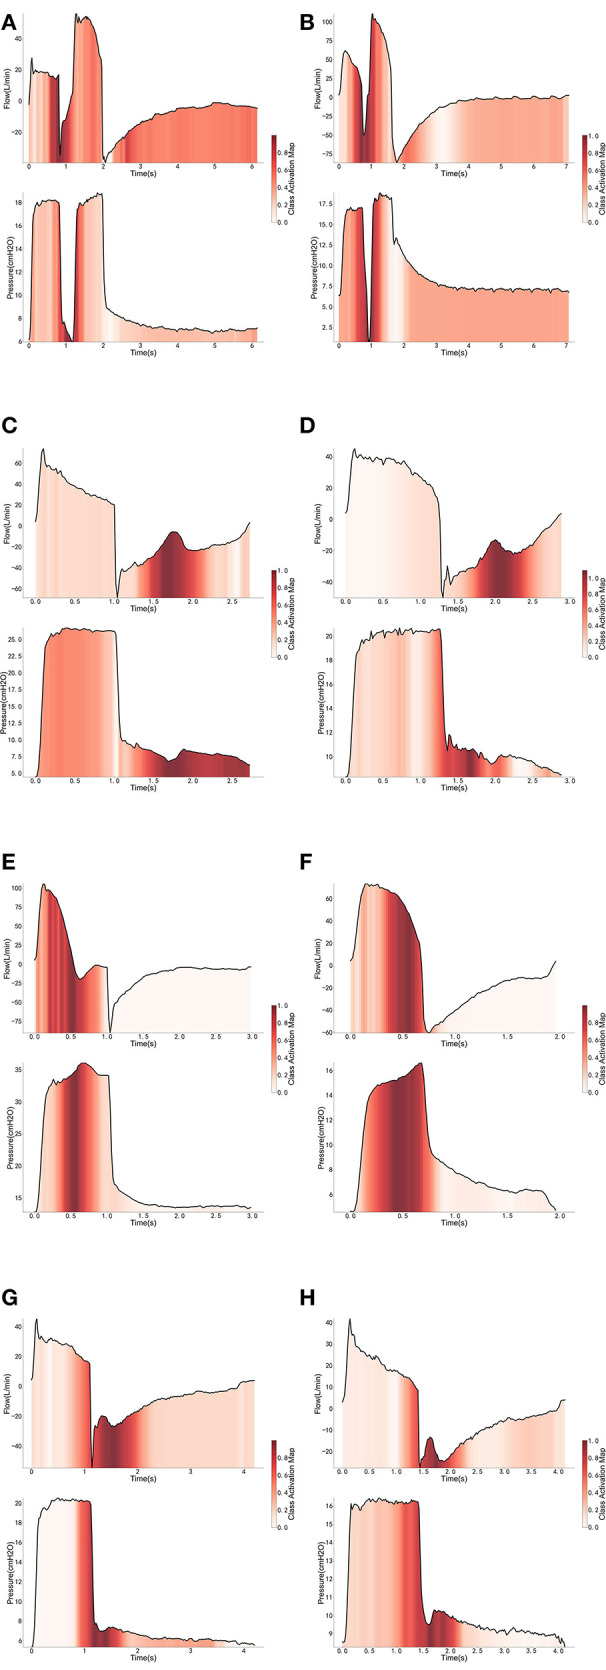
Interpretation of the cycles classified as PVA under PCV mode (A,C,E,G) and PSV mode (B,D,F,H).